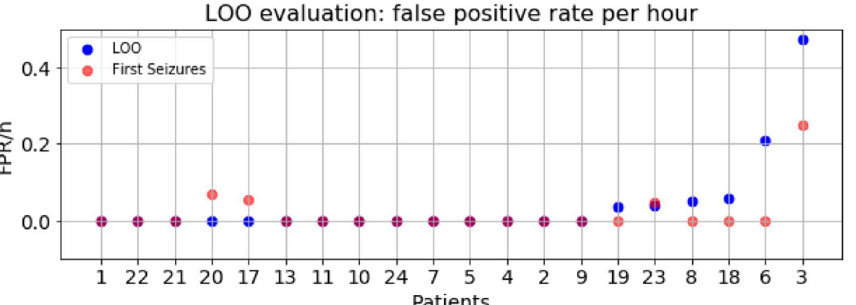
Figure 5. False positive rate per hour defined in consecutive 10s windows for the best LOO model (blue) and First Seizures model (red). Patients are sorted by increasing FPR/h. The y-axis is cut at FPR/h value of 0.5 to visualize minor differences. Patients 15, 16, 12 and 14 have values over 2 and are not shown in the